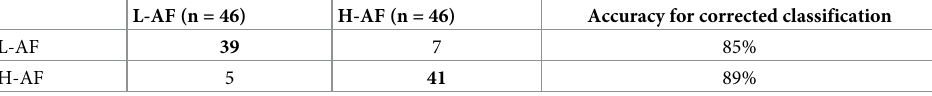
AUC = 0.87; d = 1.59; F1 = 0.87. The rule was based on SF test scores and was the following: if the semantic fluency test score is < 41 . 5 or � 41 . 5 , then the participant is classified as a low- or high-performer , respectively . L-AF , low-AF performers on the alternate fluency test; H-AF , high-AF performers on the alternate fluency test.